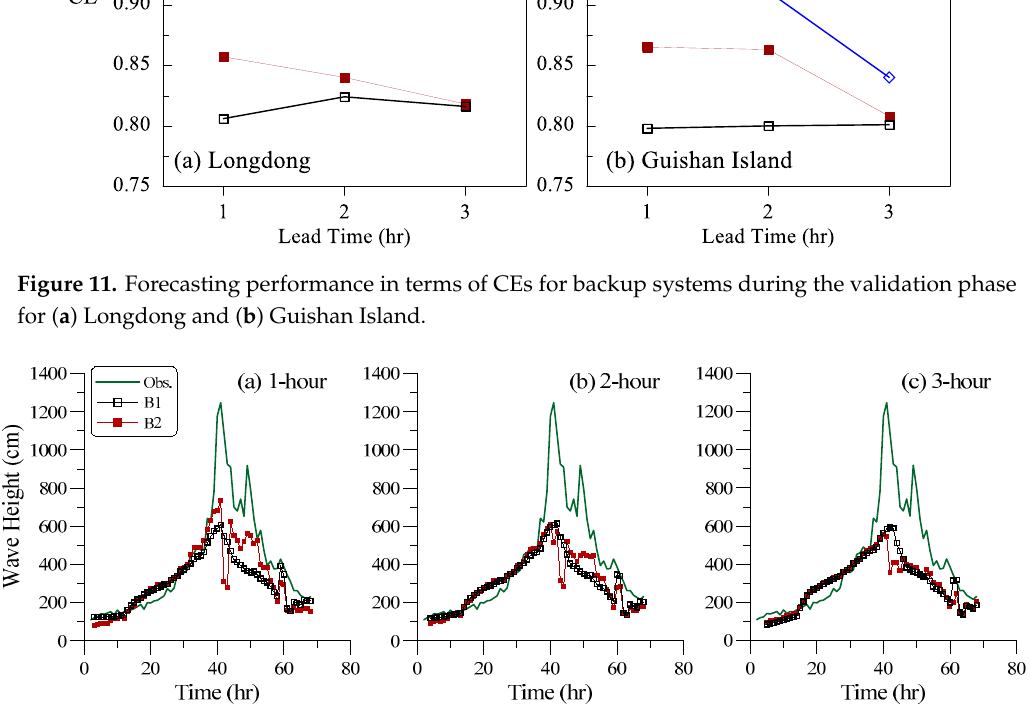
Figure 12. Wave height forecasting of backup systems with lead time of ( a ) 1, ( b ) 2, and ( c ) 3 h for Event 17 at Longdong.